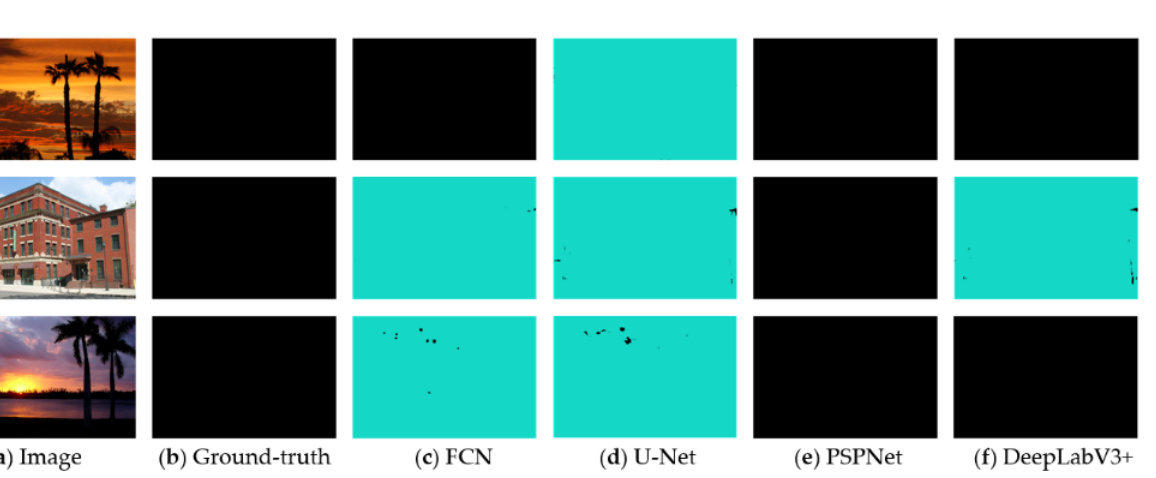
Table 4. Evaluation indicators of models .